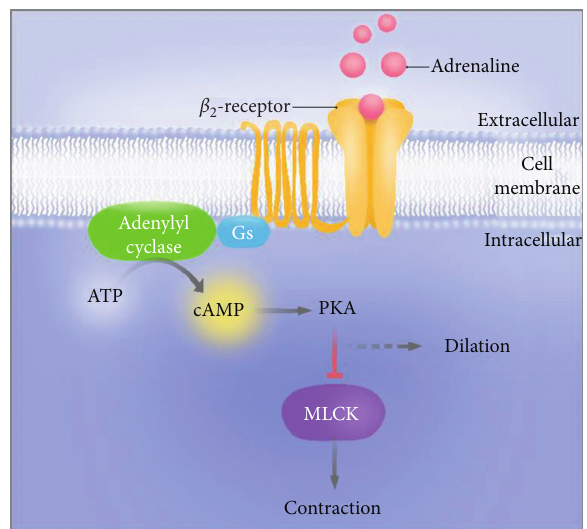
Figure 7: The β 2 adrenergic receptor is a G-protein coupled re- ceptor. Activation of the receptor by adrenaline leads to peripheral vasodilation through the Gs signal pathway. Activation of adenylyl cyclase leads to conversion of ATP to cAMP, which activates phosphor kinase A (PKA). Activation of PKA leads to deactivation of myosin light chain kinase (MLCK), which, when activated, leads to contraction. Thus, activation of PKA leads to vasodilation